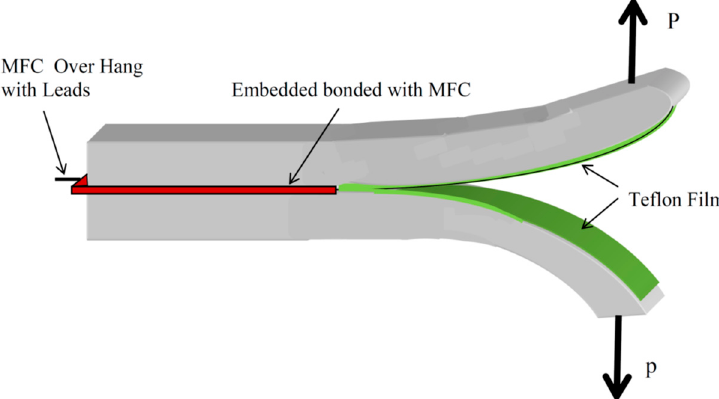
Figure 2. Double cantilever beam with microfiber composite (MFC) at the delaminating interface.